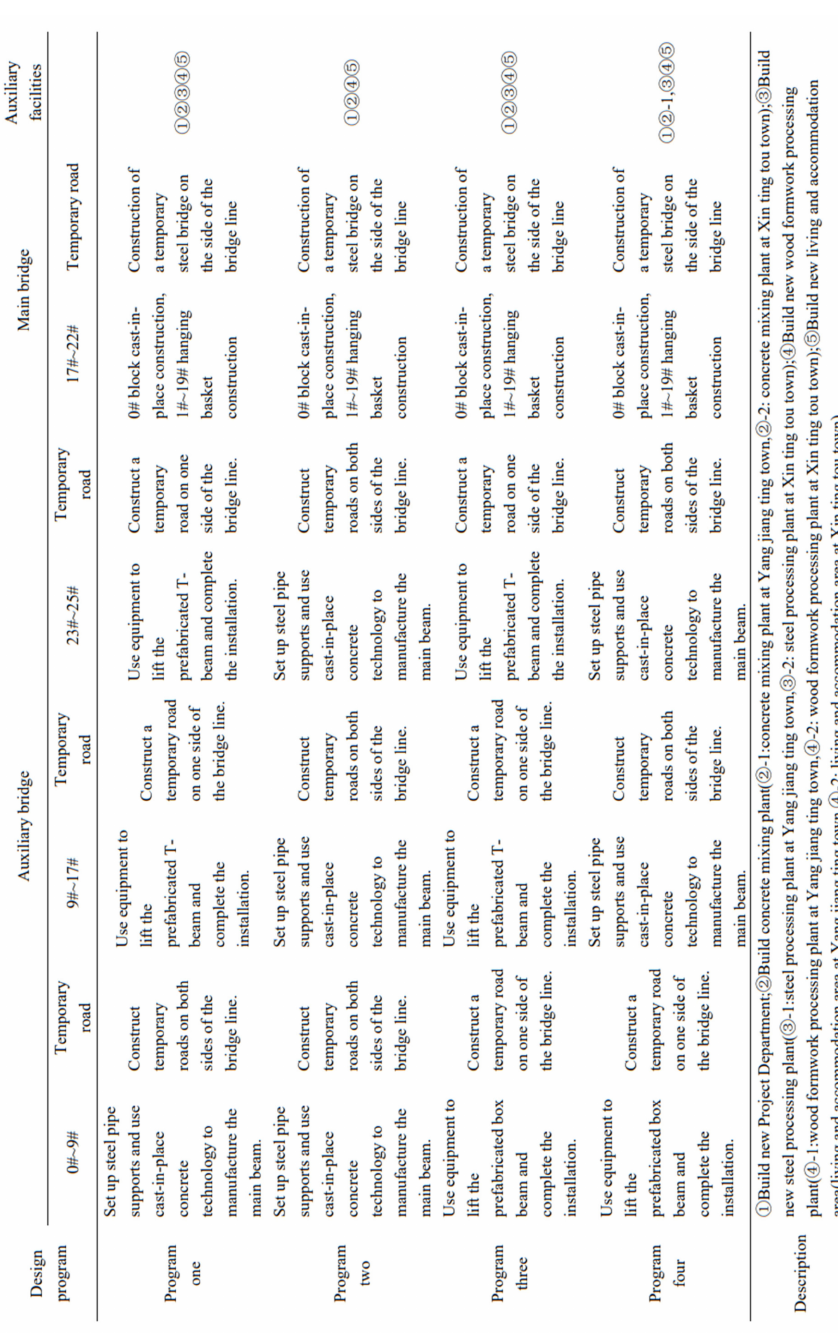
Figure 9. Description of the overall project management